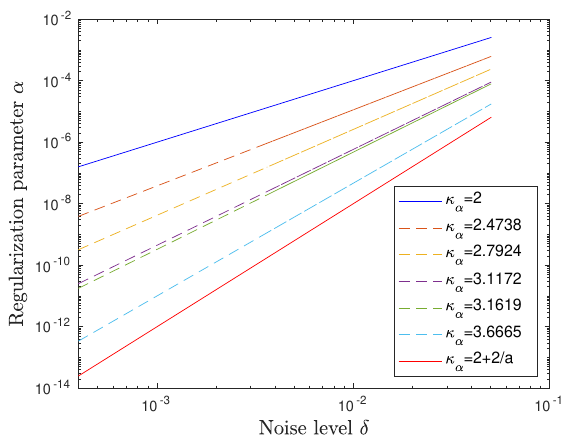
Figure 1. Regression lines for decay rates of α discr for δ → 0 and different values β from Table 1 on a double-logarithmic scale.